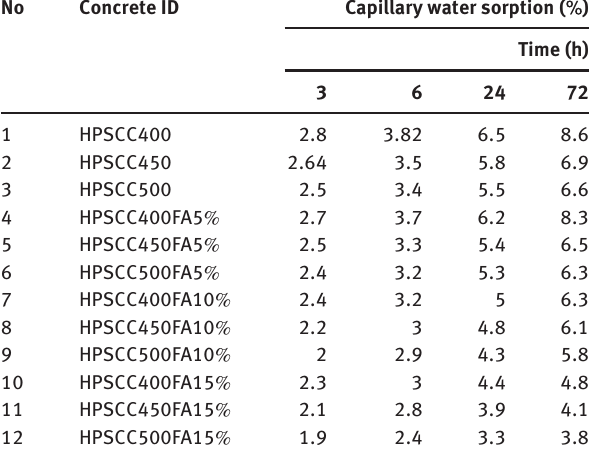
Table 10 Results of capillary absorption by time.